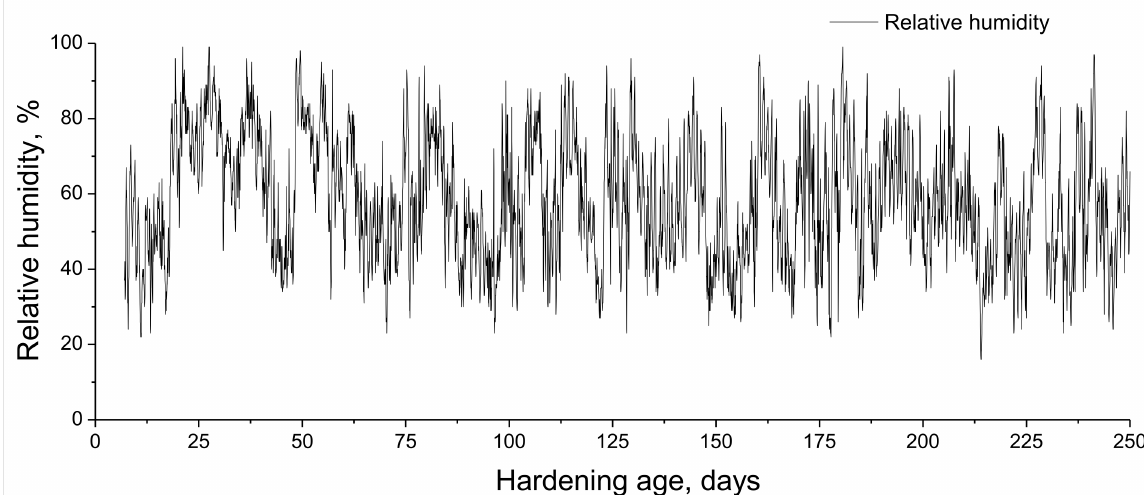
Figure 3. Relative humidity registered in the exposure station along the time period